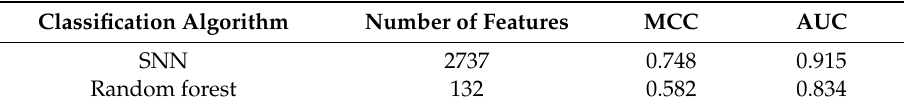
Table 1. Optimal number of features and MCC values yielded from the optimal SNN and RF classifiers.